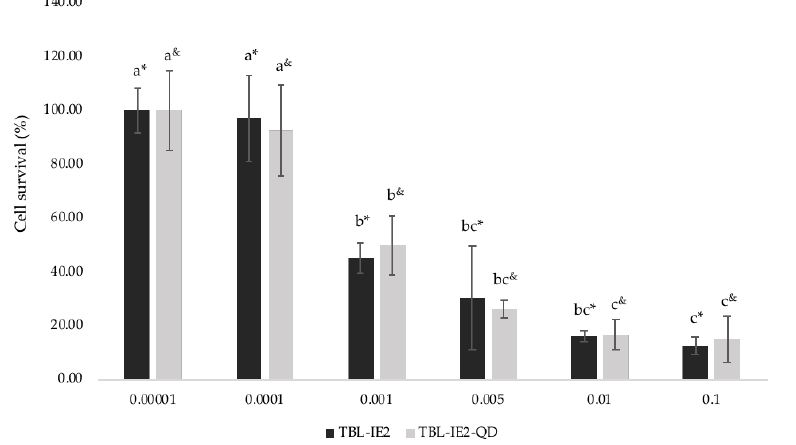
Figure 5. Cytotoxic effect of TBL-IE2 and TBL-IE2-QD complex on HT-29 cells. The cell survival percentage rate after different treatments of TBL-IE2 and TBL-IE2-QD is shown. Small letters (*) TBL-IE2 and ( & ) TBL-IE2-QD indicate statistically significant differences between concentrations for each treatment (Tukey, p < 0.05).